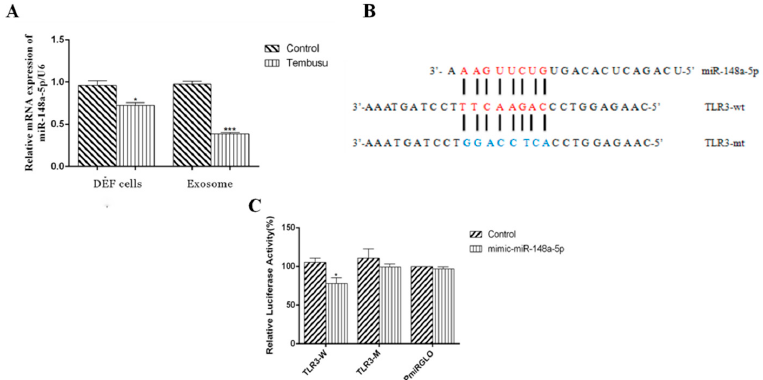
Figure 13. miR-148a-5p directly targets the TLR3 coding region in DEF cells. ( A ) miR-148a-5p expression in DEF cells and DEF-Exo is determined by qRT-PCR. U6 snRNA was used as an internal control. The average levels from three independent experiments are plotted. ( B ) is the TLR3 coding region containing the reporter constructs. ( C ) Luciferase reporter assays in DEF cells upon co-transfection of the WT (TLR3-W) or mutant (TLR3-M) TLR3 coding region with miR-148a-5p mimic and control. In ( A ) we set the control group as 1, and in ( C ) we set the control group as 100%. These experiments were performed in triplicate, and the results are shown as mean ± SEs * P < 0.05, ** P < 0.01.